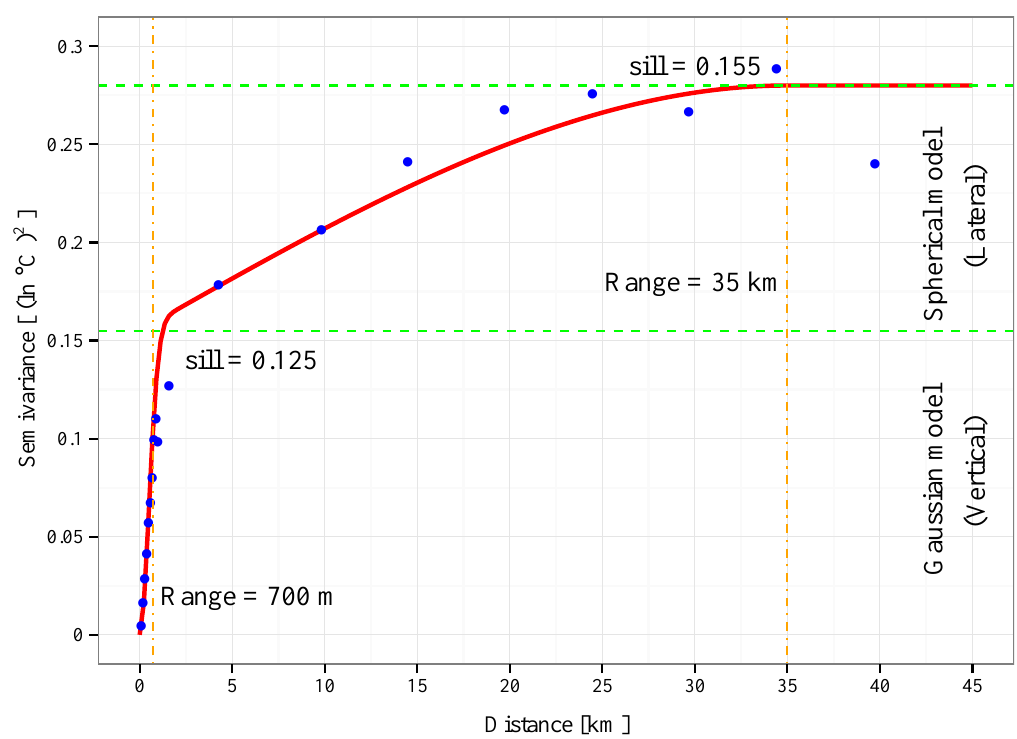
Figure 8. Nested 3D variogram model (red curve) showing a mixture of two spatial correlation structures of temperatures data, short along the vertical direction and long along the lateral direction. The blue dots, green dashed lines, and orange dashed lines reflect experimental variograms, sills, and ranges,